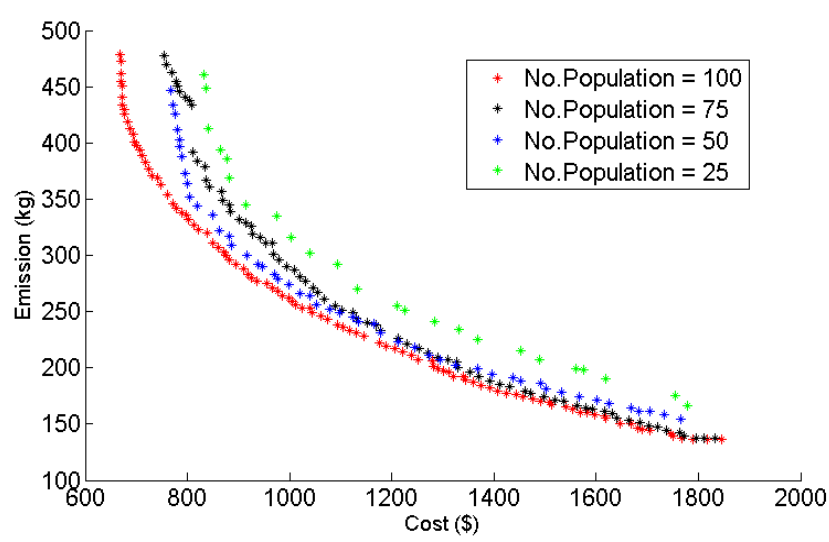
Figure 15. Impact of population changes on the Pareto Front (cost and emission based).